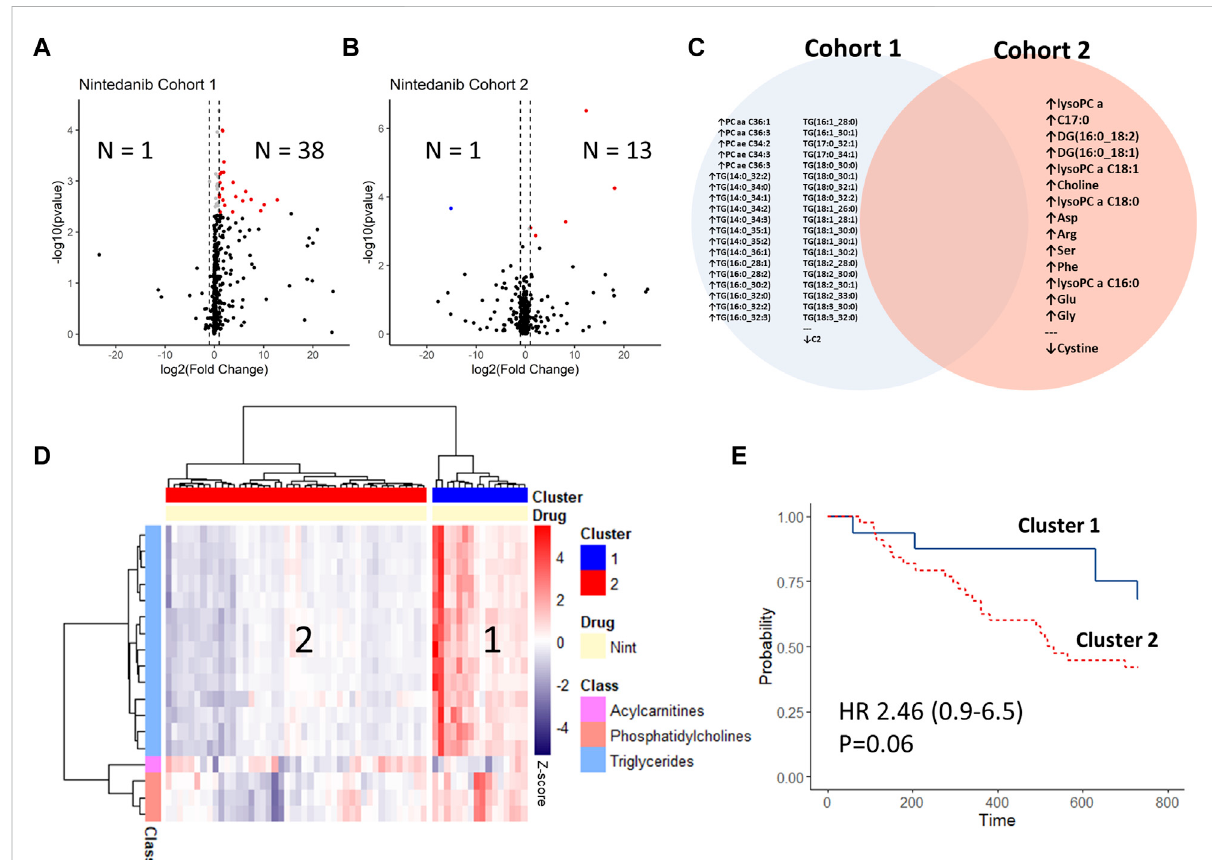
FIGURE 4 Changes in longitudinal analysis before vs. after initiation of anti fi brotic treatment with nintedanib. Log2-Fold changes were plotted against -log10 ( p -value) of cohort 1 (A) and cohort 2 (B) as volcano-plots with numbers of signi fi cantly (FDR < 0.05) up or down-regulated analytes indicated (sample after treatment vs. baseline). The deregulated analytes in both cohorts are shown in (C) , with no overlap between the cohorts. Delta-values (sample after treatment vs. baseline) of cohort 1 were calculated per patient and changes between the de-regulated analytes were plotted via heat-mapwithhierarchicalclustering (ward.D method) (D) .TheresultingpatientclusterswerethencomparedviaKaplan-Meiercurvesand adjusted cox-regression modelling (for GAP-index) (E)